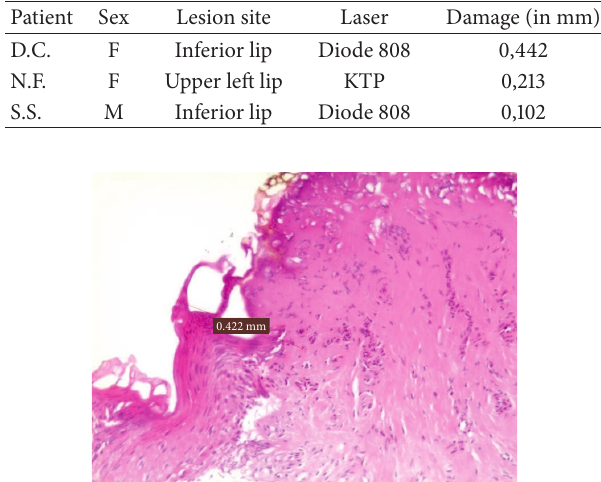
Figure 1: Damage measurement in a mucocele.